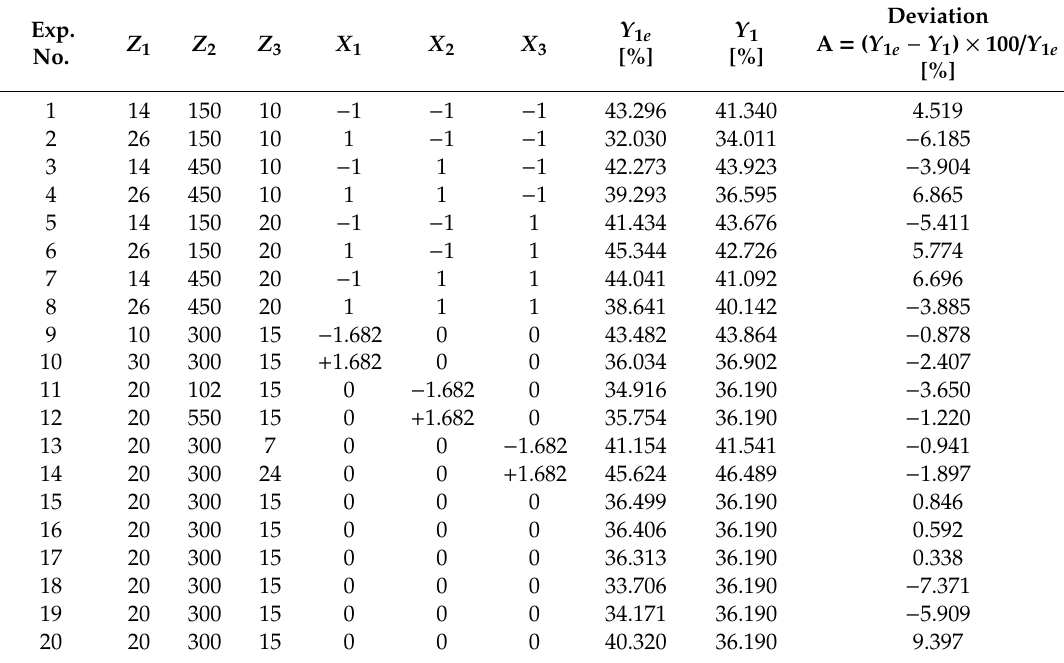
Table 4. Experimental planning matrix for Y 1 (suspended solids removal).